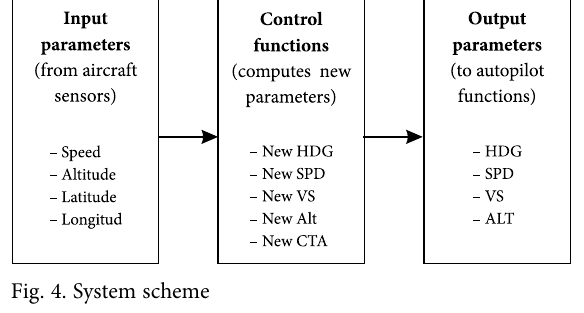
Fig. 4. System scheme